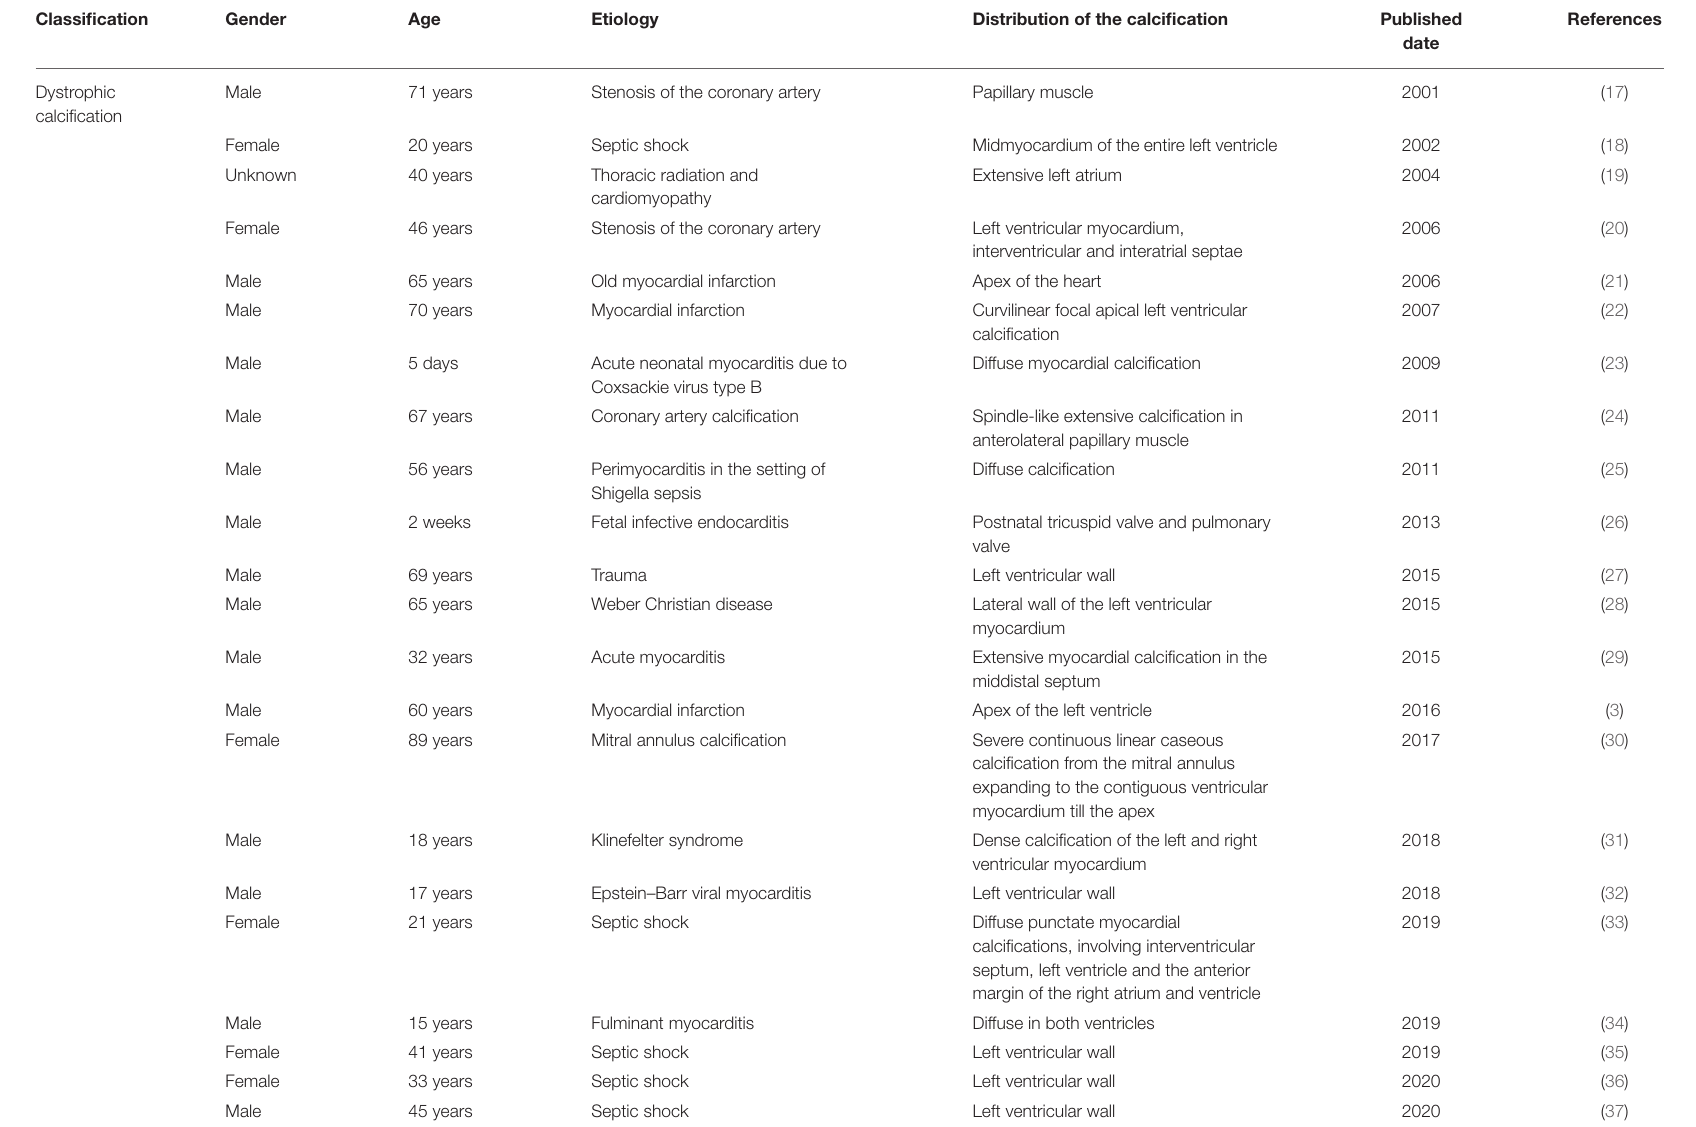
TABLE 1 | Demographic and clinical characteristics of patients diagnosed with cardiac calcification.